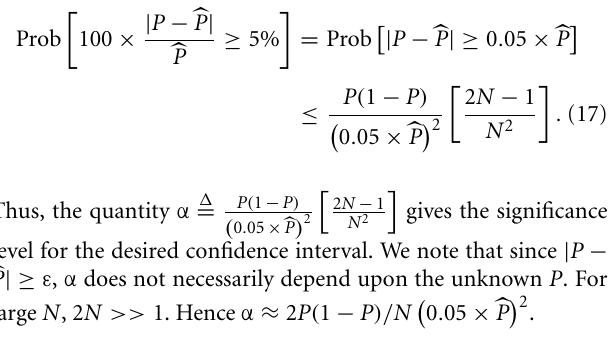
maximum deviation of the estimate from the true value, the average deviation, and the minimum deviation were computed. The corresponding values of e are alsoplottedonallthegraphs.Theeffectofvarying( α = 0 . 01and0.05)forafixed ( N = 100)isshownintheleftandmiddlecolumns.Theeffectofvarying( N = 100 and 250) for a fixed ( α = 0 . 05) is shown in the middle and right